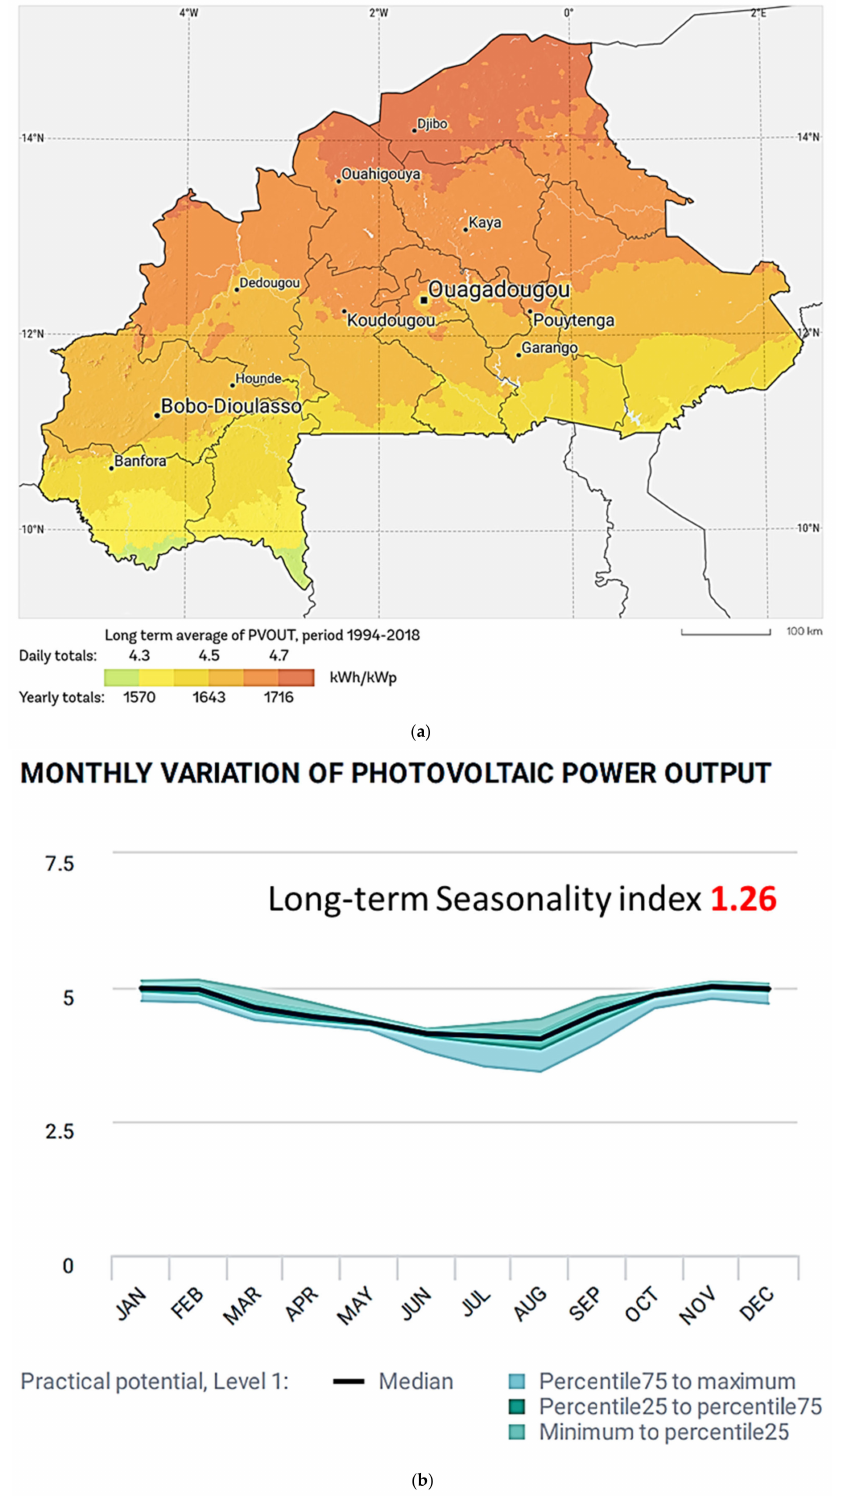
Figure 4. ( a ) Long-term photovoltaic power potential, and ( b ) monthly variation of